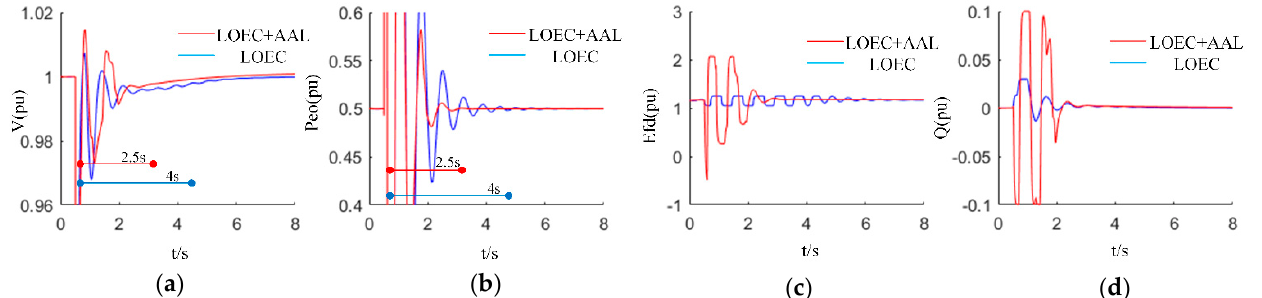
Figure 10. Comparison of coordinated control and traditional control under the three phase remote fault. ( a ) terminal voltage ( b ) active power ( c ) field voltage ( d ) reactive power injection.